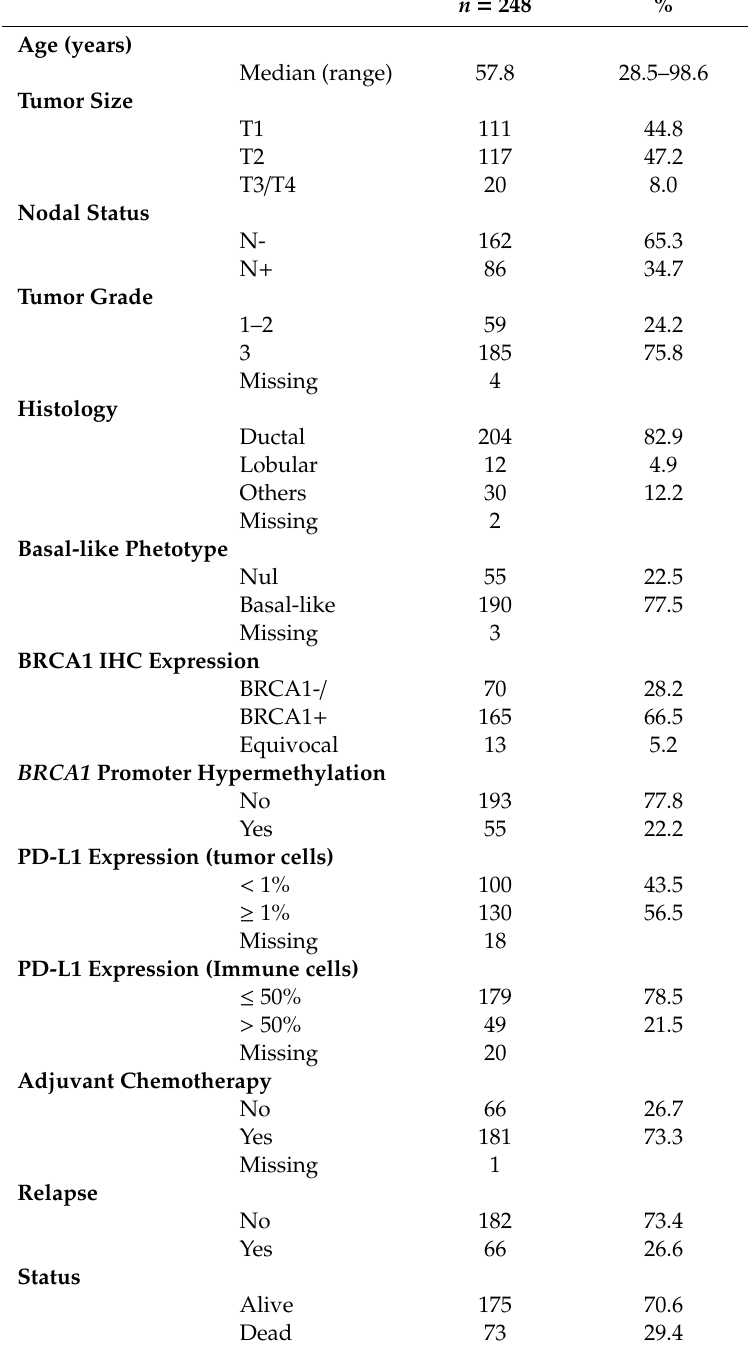
Table 1. Patients and tumors